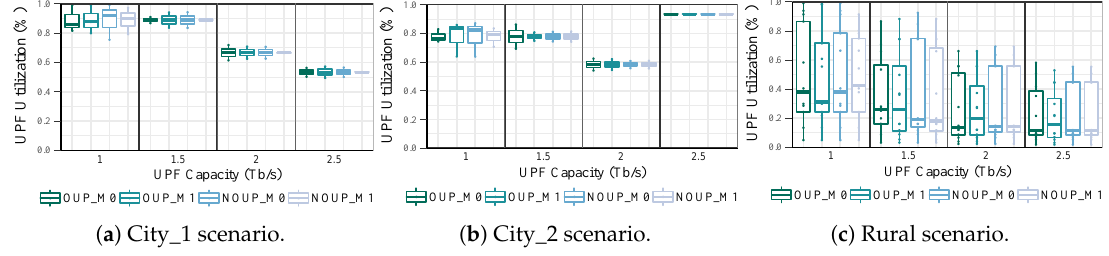
Figure 7. UPF Utilization vs. capacity for services with high requirements.